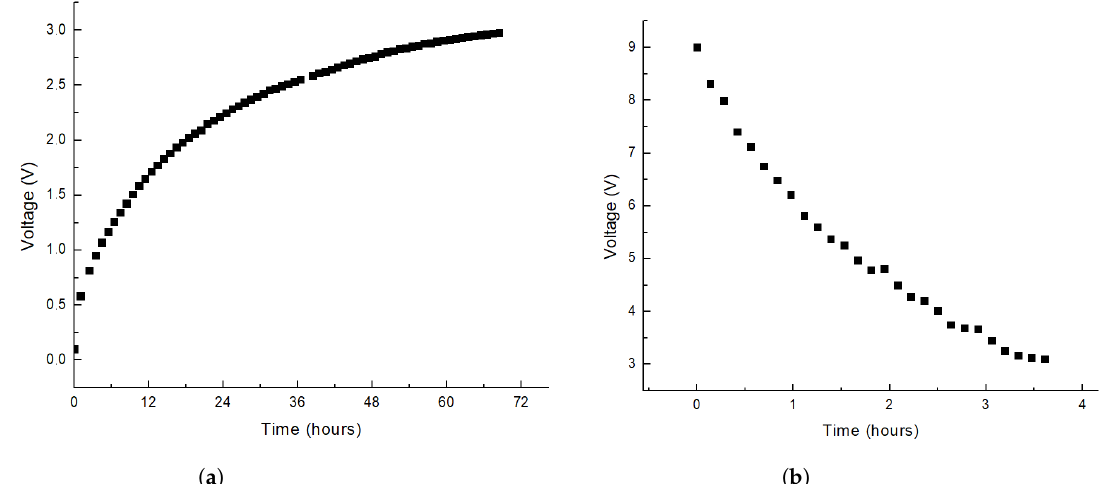
Figure 10. BERS characterisation: when discharging, the energy-storing unit was under 3 V. ( a ) Time needed to activate the BERS. and ( b ) BERS discharge time with pH